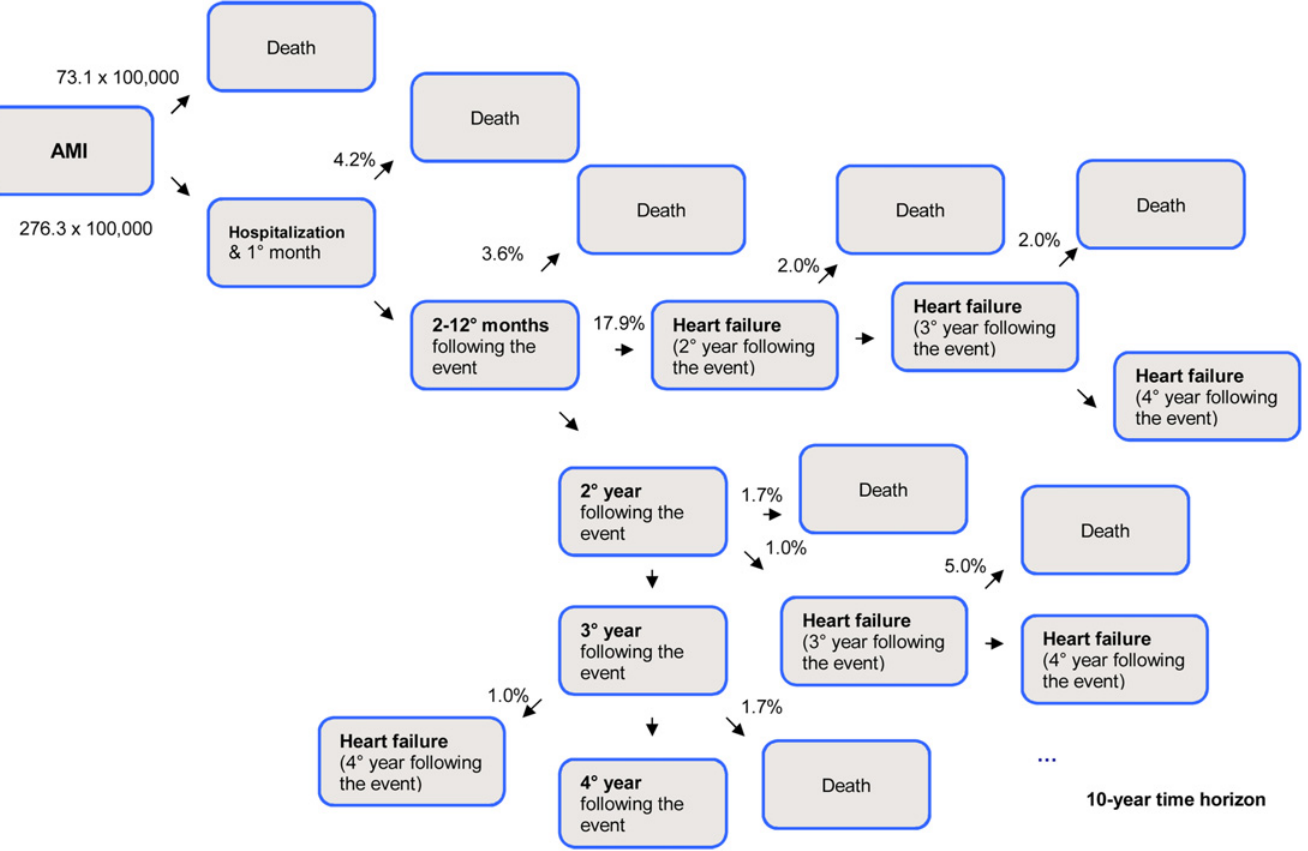
Fig 2. Schematic representation of first 4 years ’ model: acute myocardial